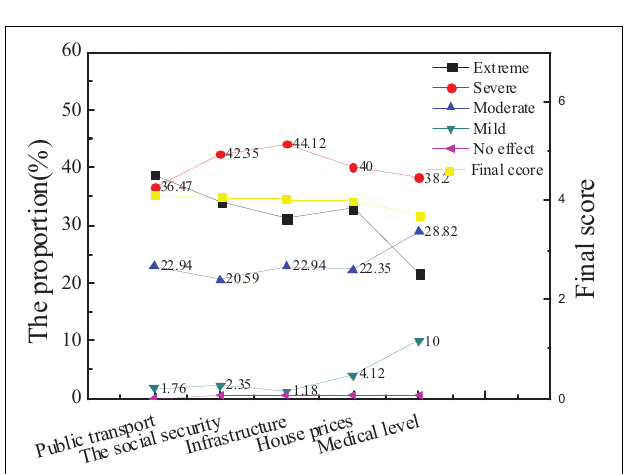
FIGURE 6 | Attention and scores of the audiences on the influencing factors of city social image.